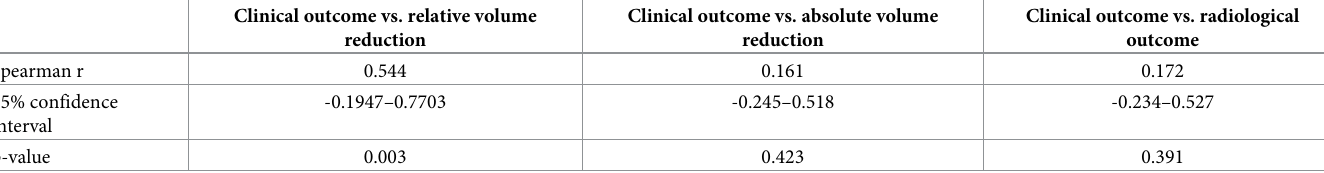
Table 3. Correlation analysis.